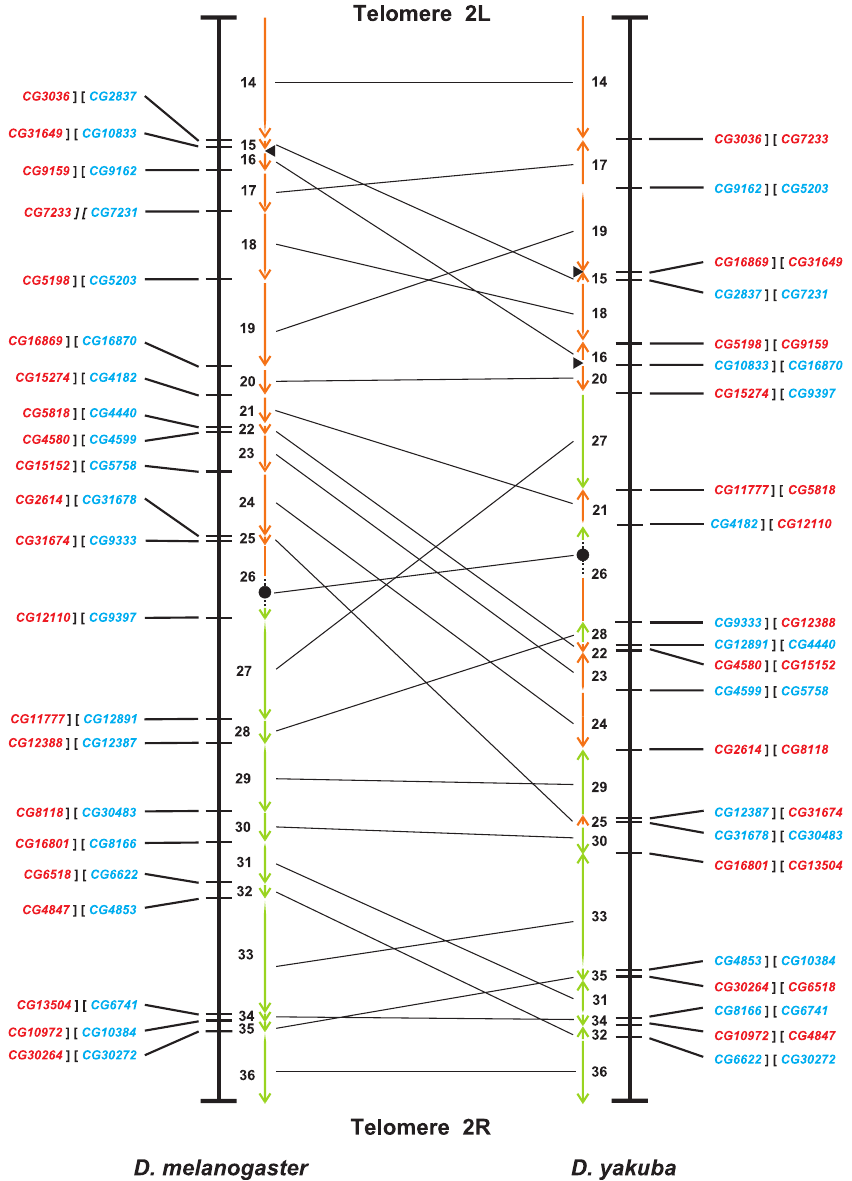
Figure 3. Large-Scale Comparison of the Genomes of D. melanogaster and D. yakuba . Muller’s Elements B and C (chromosome 2) Similar plots are shown for Muller’s element A (chromosome X) and Muller’s elements D and E (chromosome 3) in Figure S4A and S4B, respectively. The outermost protein-coding genes of consecutive syntenic blocks are indicated. Following Bridges [116], syntenic blocks (defined as regions in which the relative gene order is globally conserved between D. melanogaster and D. yakuba ) are numbered taking D. melanogaster as a reference and in an increasing order from the telomere of chromosome X (number 1) to the telomere of the right arm of chromosome 3 (number 58); an arrowhead indicates the orientation of the segments. Lines between chromosomes match homologous syntenic blocks between species. The pericentric inversion between Muller’s elements B and C during the divergence of D. melanogaster and D. yakuba is shown by a color code, whereas syntenic blocks on the left and right arms of D. melanogaster appear in orange and green, respectively; the syntenic block that contains the centromere, number 26, is not colored. The solid triangles denote the gene CG6081 , whose duplication accompanied the origin of the inversion 2L(2) (Figures 2, S2, and